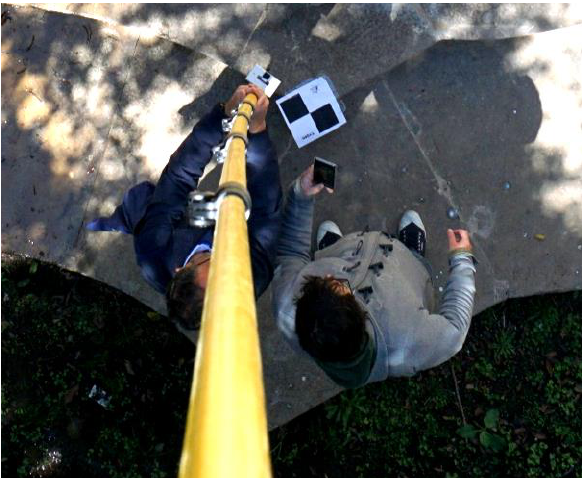
Figure 5. The telescopic rod used for survey operations.